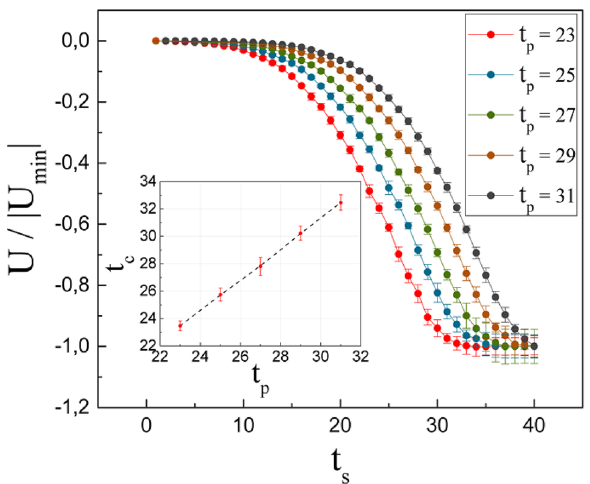
Figure 4. Normalized energy as a function of time for different values of t p . Inset: t c as a function of t p .